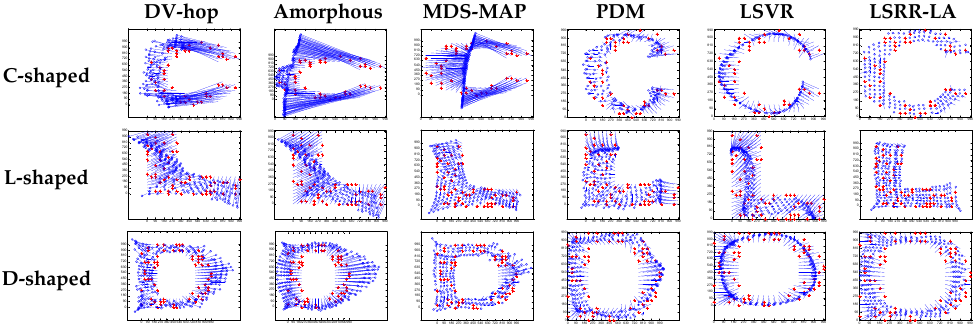
Figure 4. The localization results of the six algorithms in regular distribution networks ( R = 100m, M = 20%).